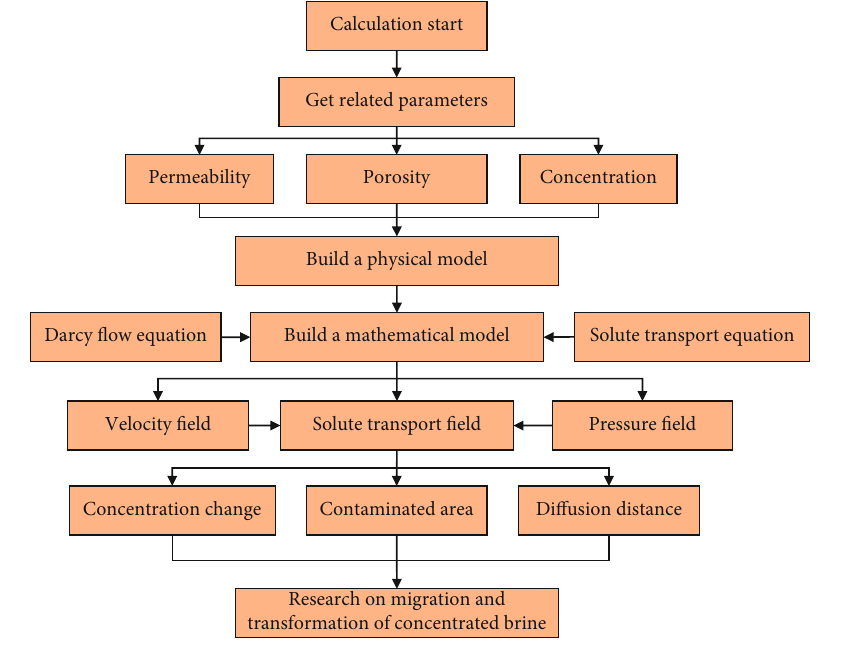
Figure 5: Block diagram of the calculation process.